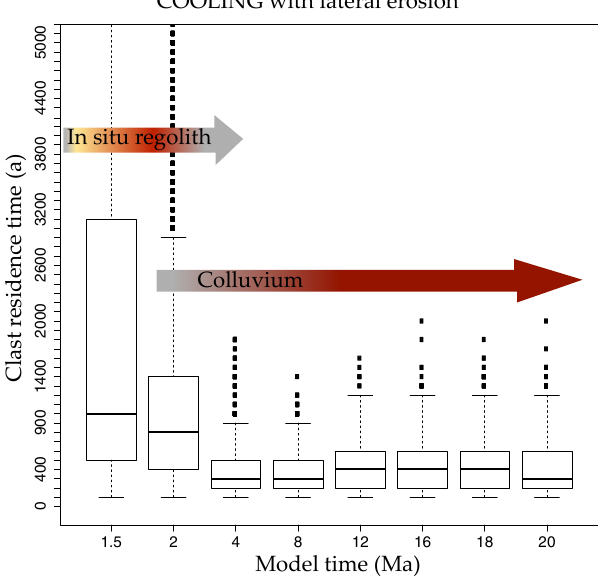
Figure 6. Distribution of the residence times for the clasts at differ- ent steps of the evolution in the COOLING experiment with lateral erosion (Fig. 5a and c). The clast residence time is defined as the time during which a clast weathers (e.g. Dosseto et al., 2006; Mudd and Yoo, 2010), either in the regolith on the hillslopes, or in the colluvium. Note that the distribution is cut at 5ka, but residence times of several tens of thousands of years are present at 1.5Ma, al- though they constitute much less than 1% of the clasts. After 6Ma, the regolith has completely disappeared, so that the residence times represent the time spent after their detachment from the bedrock, i.e. primarily within the colluvium and possibly sediment temporar- ily deposited by the rivers. This distribution of the residence times gives an estimate of the colluvium residence times along the valleys. Of the residence times, 99% are smaller than 1.5kyr after 4Ma. This distribution increases slightly after 6Ma because the rainfall decreases. The increase in residence time compensates for the rain- fall decrease to produce the nearly constant weathering outflux seen in Fig. 5.